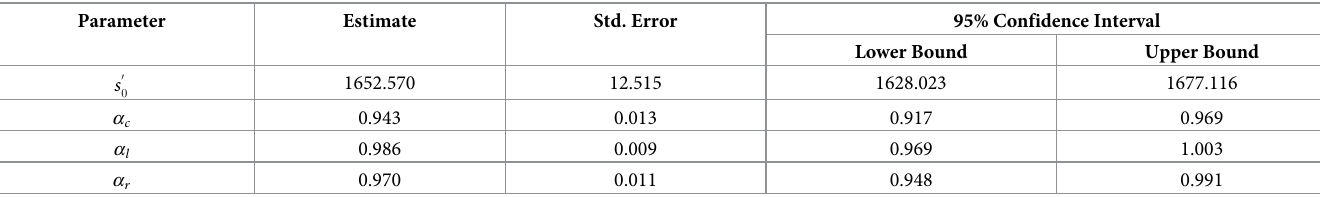
Table 4. Parameter estimation.